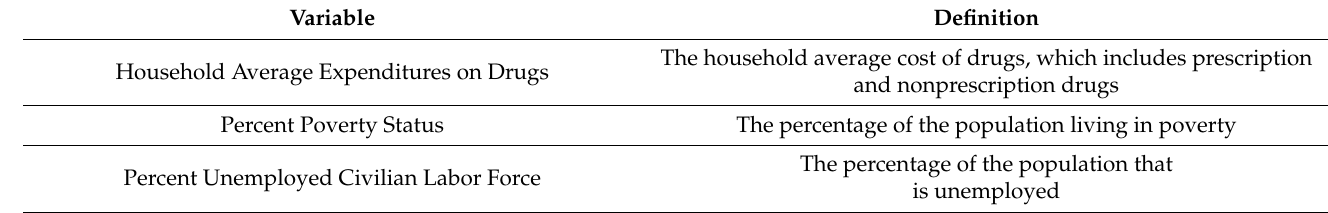
Table 3. Simply Analytics Variable